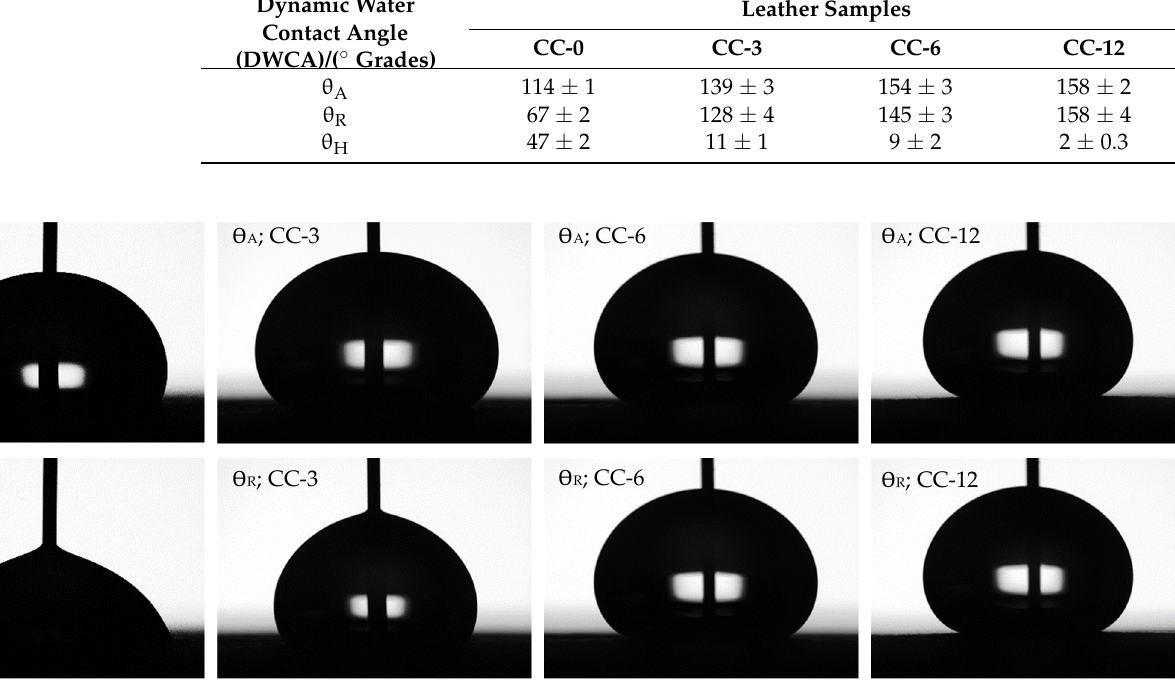
Figure 9. Evolution of the dynamic water contact angles as a function of HMDSO plasma deposition time on leather samples. 4. Conclusions This study has proposed the use of low-pressure plasma technology to alter the sur- face properties of leather to make it hydrophobic, thus increasing the usage of leather. A one-step plasma polymerisation coating process with an organosilicon precursor (HMDSO) on leather for footwear application was investigated using an LPP system and optimising the working parameters. It was observed that in LPP polymerisation, the dep- osition time was a key parameter for the proper formation, cross-linking and coating of the ultra-thin layer created by the siloxane on the leather surface. The suitable plasma hydrophobisation process of the leather material is supported by the following physio- chemical evidence concluded from the results obtained in this research: -